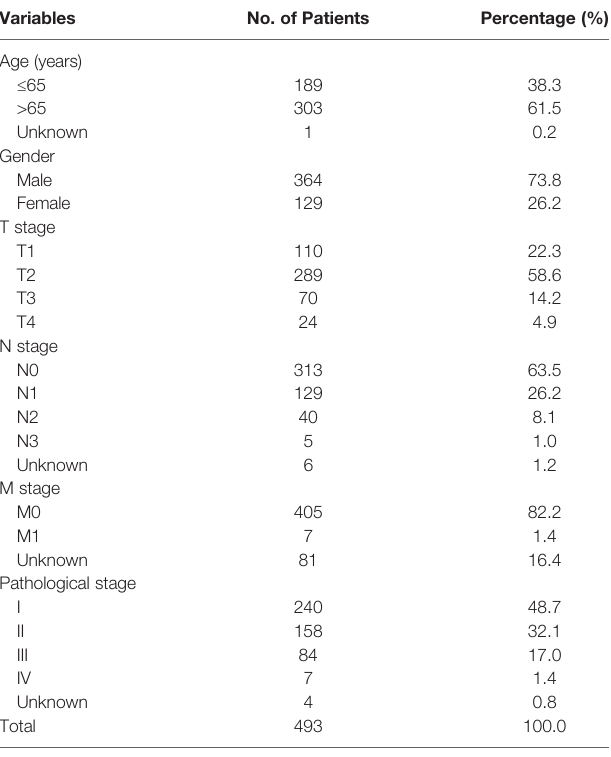
TABLE 1 | The clinical characteristics of lung squamous cell carcinoma patients in the training cohort. Variables